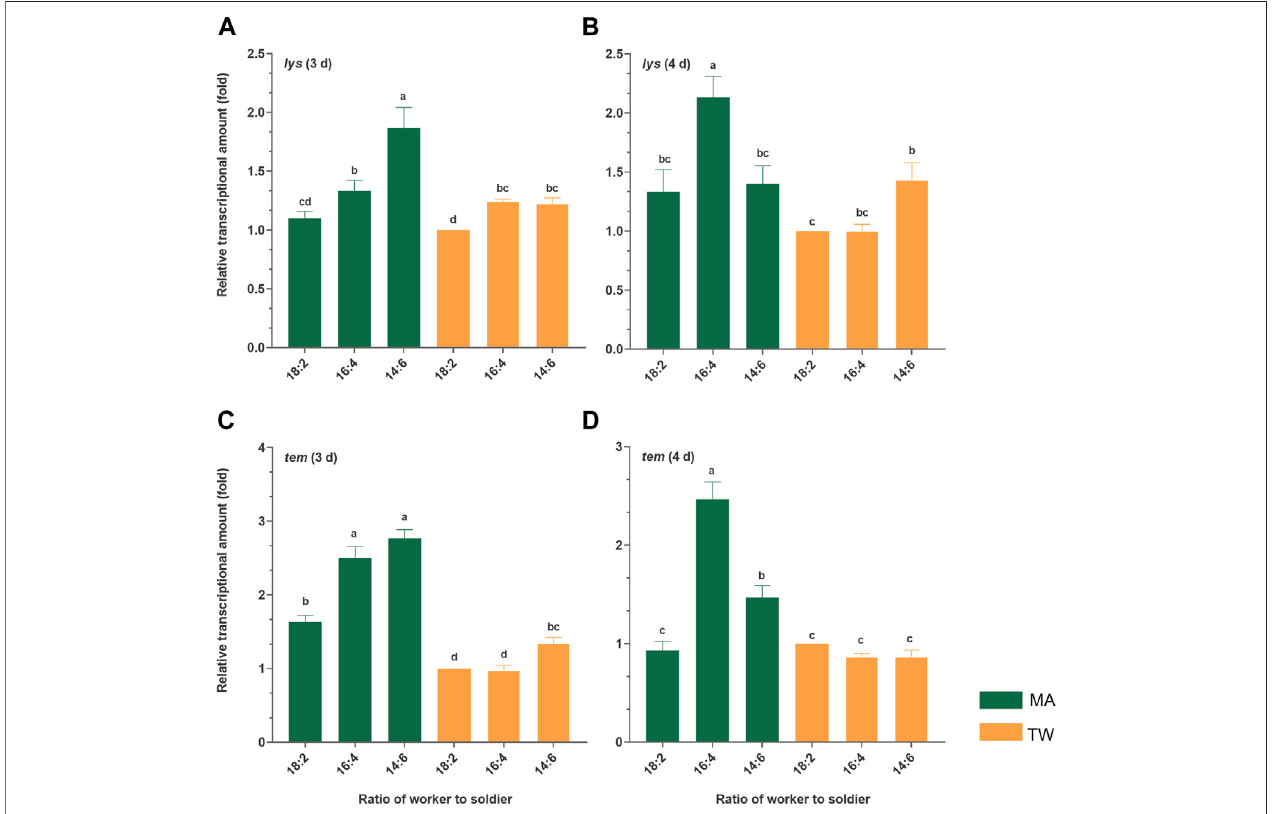
FIGURE 4 | Relative transcriptional amount of the two immune genes in the Metarhizium anisopliae- infected worker Coptotermes fomosanus . The termites of the group 18:2 treated with 0.1% Tween-80 solution were used as controls, and the relative expression levels of the speci fi c genes were normalized to that of the reference gene, GADPH . The error bars represent the mean ± SEM. Different letters indicate signi fi cant differences among the six sets of data within a time phase (one-way ANOVAs,LSD, p < 0.05). Theletters “ (A – D) ” at the top ofthepicture representthe identi fi ers ofthefour histograms, respectively. tem ,termicin; lys ,lysozyme;MA, M. anisopliae -infected group; TW, Tween-80-treated control group.